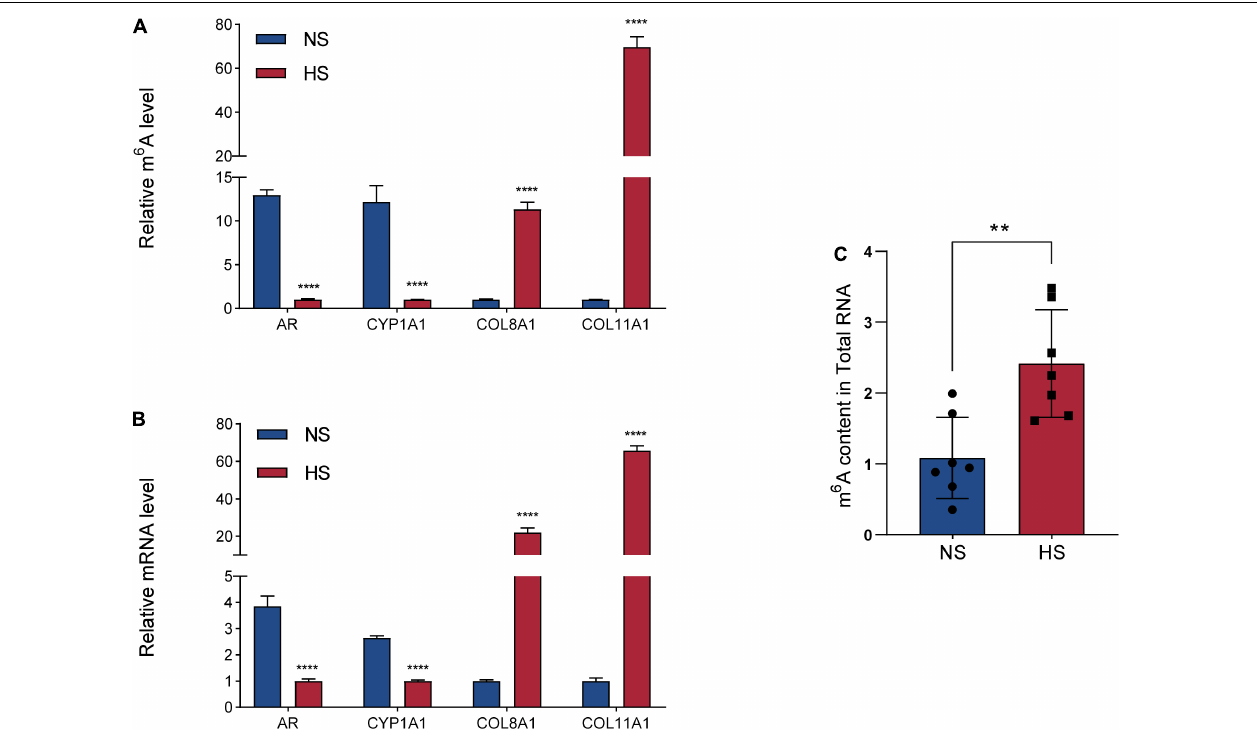
FIGURE 5 | Gene-specific m6A qPCR assays and detection of global m 6 A levels. (A) Gene-specific m 6 A qPCR validation of m 6 A level changes of four representative hypermethylated or hypomethylated genes in the normal skin (NS) and hypertrophic scar (HS) groups. (B) Relative mRNA levels of four representative genes were measured by real-time PCR in the NS and HS groups. (C) m 6 A/A ratio of polyA-RNAs isolated from the NS and HS samples were determined using the m 6 A RNA Methylation Assay Kit. The bar shows the mean from n = 7 technical replicates. ** P = 0.0030, **** P <